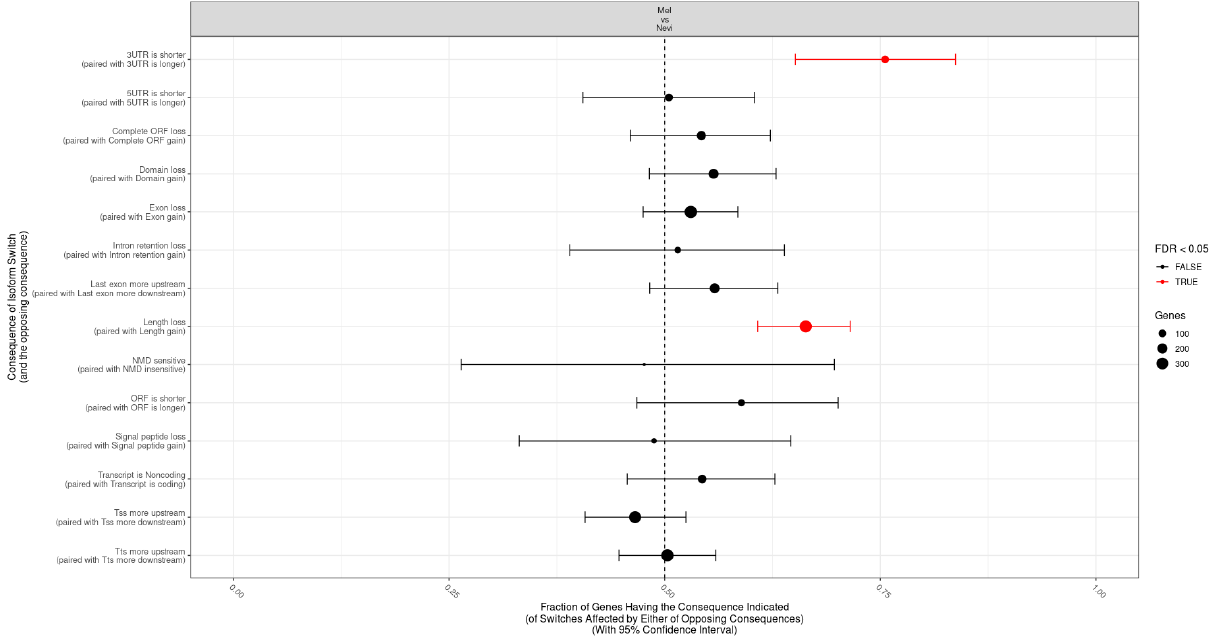
Figure 5. Transcriptomic consequences of isoform switches between melanoma and nevus samples. The fraction of genes (x axis) with indicated consequences (y axis) when comparing melanomas to benign melanocytic nevi is shown.